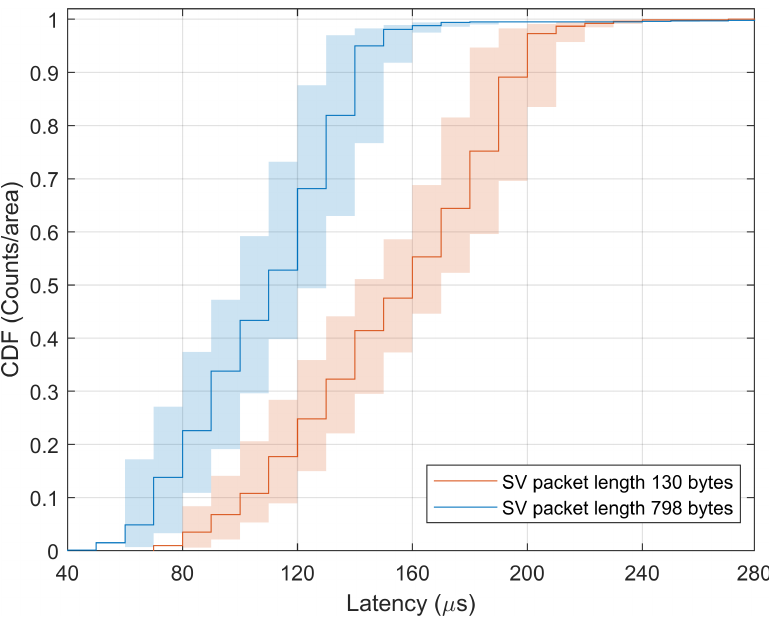
Figure 6. Cumulative distribution functions of the transmission latency of the first SV packet (with a size of 798 and 130 bytes in blue and red, respectively) with respect to the rising edge transition of the PTP time reference. Shaded areas represent the statistical uncertainty with coverage factor k =